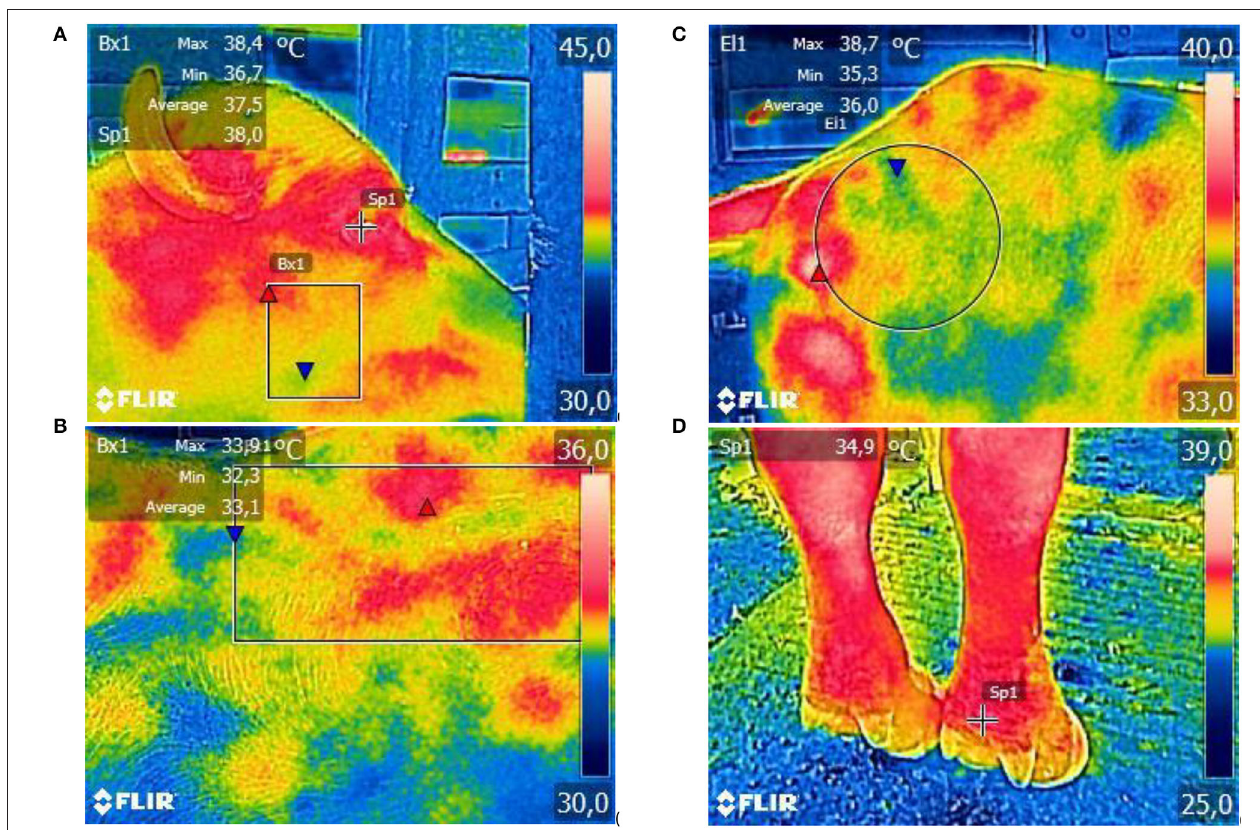
FIGURE 1 | Illustrative images of thermographic images taken to assess STs of the eyeball and cheek (A) , trunk (B) , rump (C) , and forelimb (D) of adult female buffaloes. Images parametrized for the rainbow color palette and automatic thermal scale.